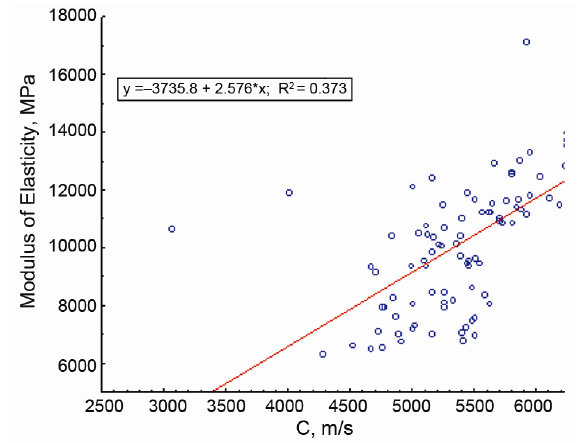
Fig. 4. Relation between max. bending strength and C (longitu- dinal direct measurement between the end surfaces in the longi- tudinal direction)